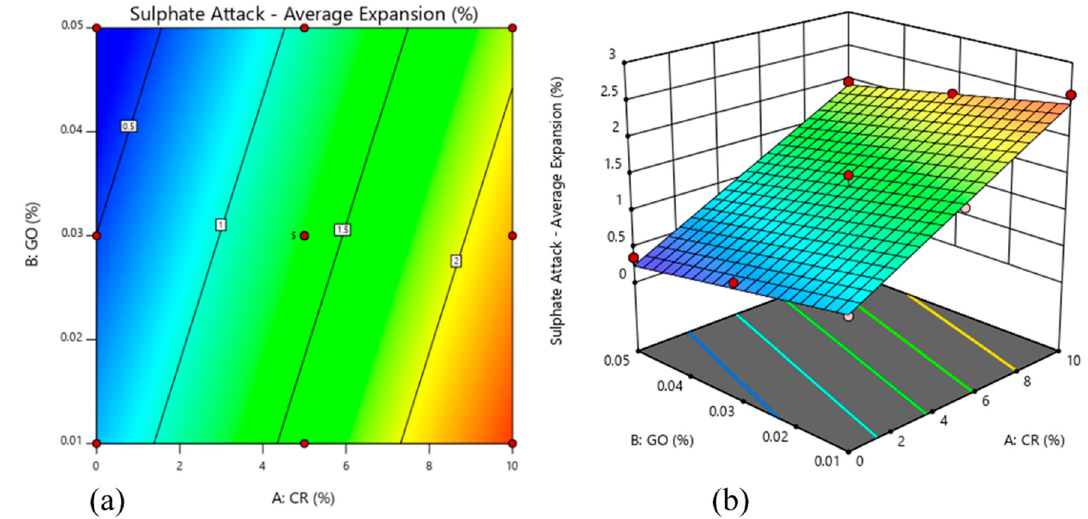
Figure 11. Sulphate attack of rubberized ECC with GO: ( a ) 2D contour plot and ( b ) 3D surface